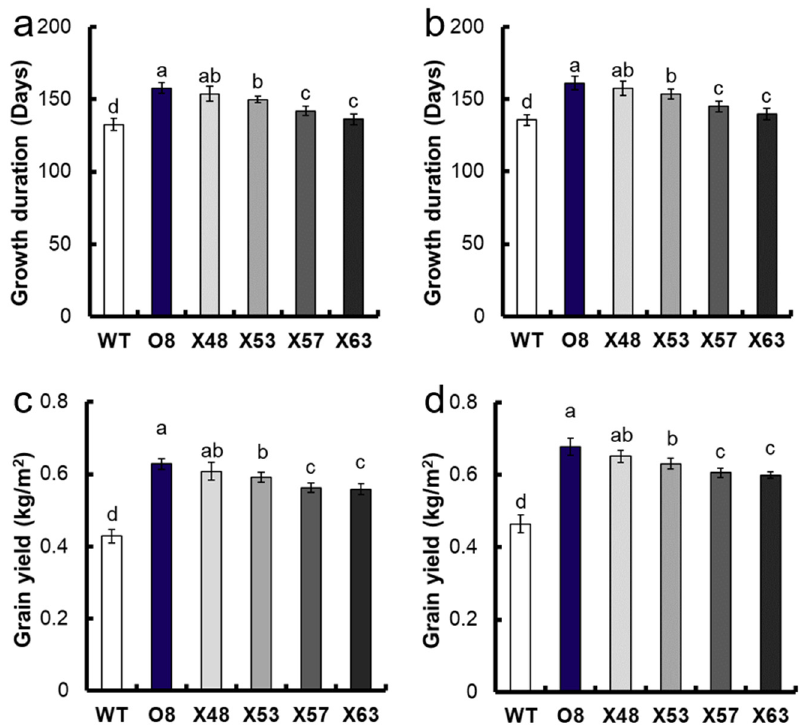
Figure 2. Growth duration and grain yield of EMS mutants in M4 and M5 generations. Growth duration of EMS mutants in ( a ) M4 and ( b ) M5 generations. Error bars: SE ( n = 10 plants). Grain yield of EMS mutants in ( c ) M4 and ( d ) M5 generations. Error bars: SE ( n = 3). Significant differences between the WT and OsNRT2.3b overexpressing lines are indicated by different letters ( p < 0.05, one-way